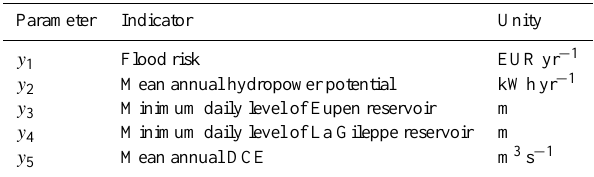
Table 4. Indicators for the reservoir